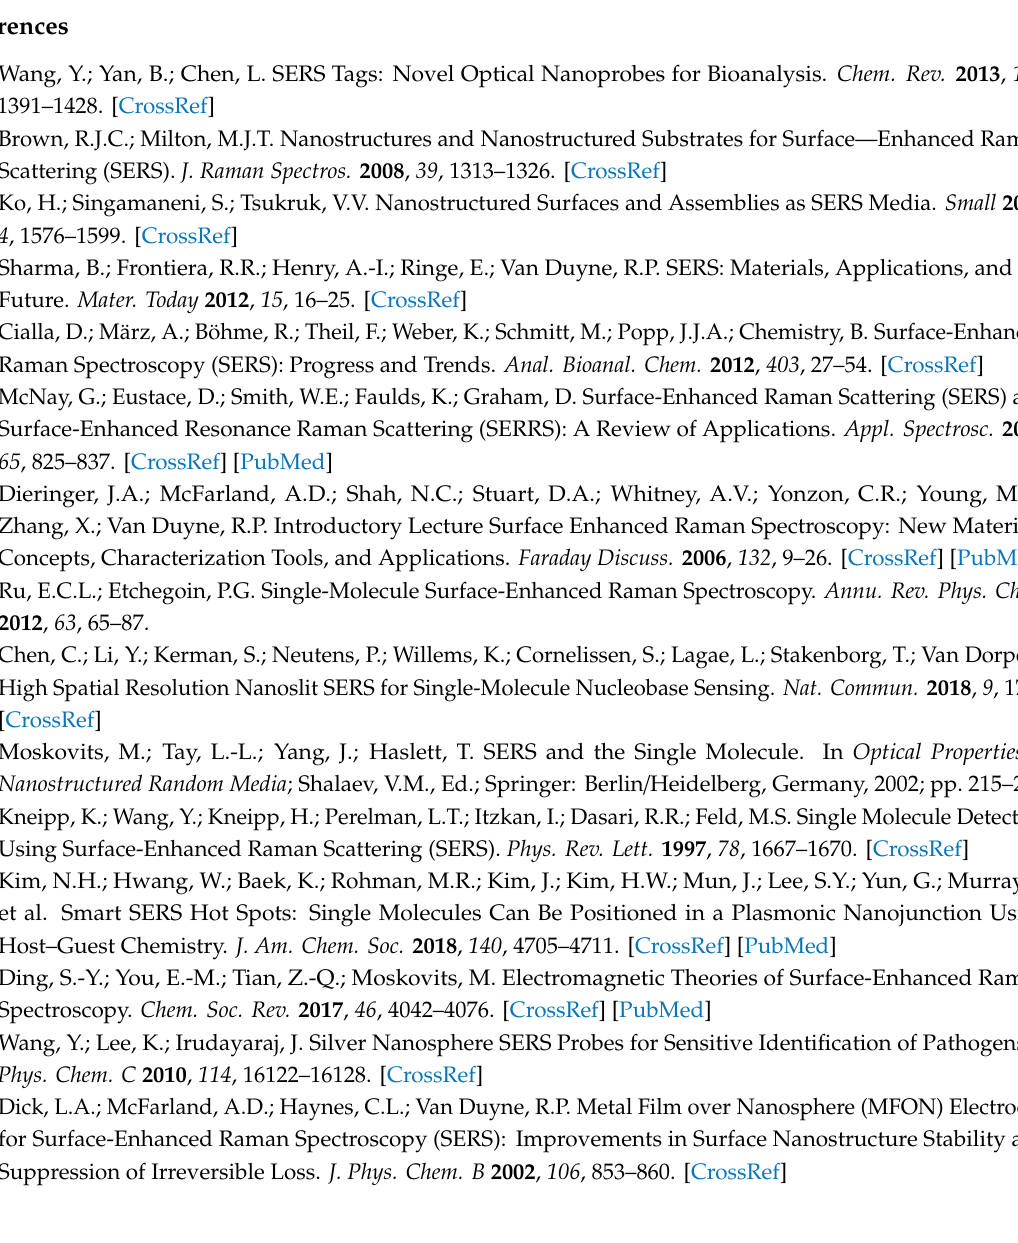
Figure S1: SEM images of monolayer Au nanorings without and with Ag cover and their corresponding EDS data, Figure S2: SEM image of Au nanorings self-assembled in LB process using di ff erent concentration of MPTMS in the solution, Figure S3: UV-vis-NIR spectrum of the Au nanorings, Figure S4: SERS intensities from blank Ag substrate and monolayer Au nanorings, Figure S5: hFM Height profiles of di ff erent thickness of Ag cover films, Equation (S1): wavelength of Raman scattering, and equations for simulation